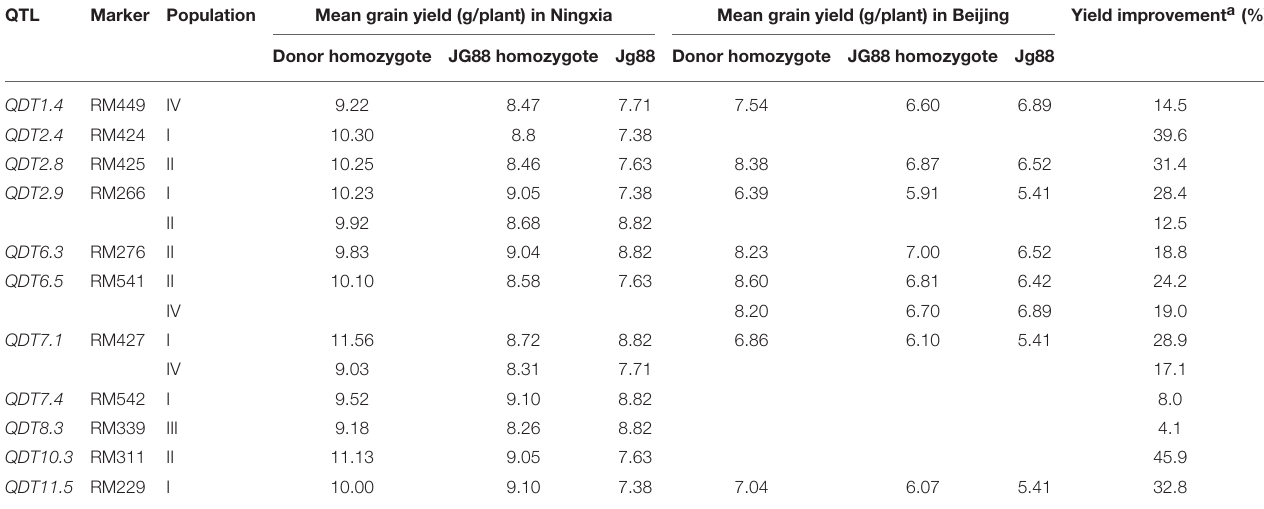
TABLE 5 | Phenotype validation of DT QTLs by comparing mean grain yields of QTL genotypes of the four random populations in Ningxia (2013) and Beijing (2012) under the drought condition. QTL Marker Population Mean grain yield (g/plant) in Ningxia Mean grain yield (g/plant) in Beijing Yield improvement a (%)